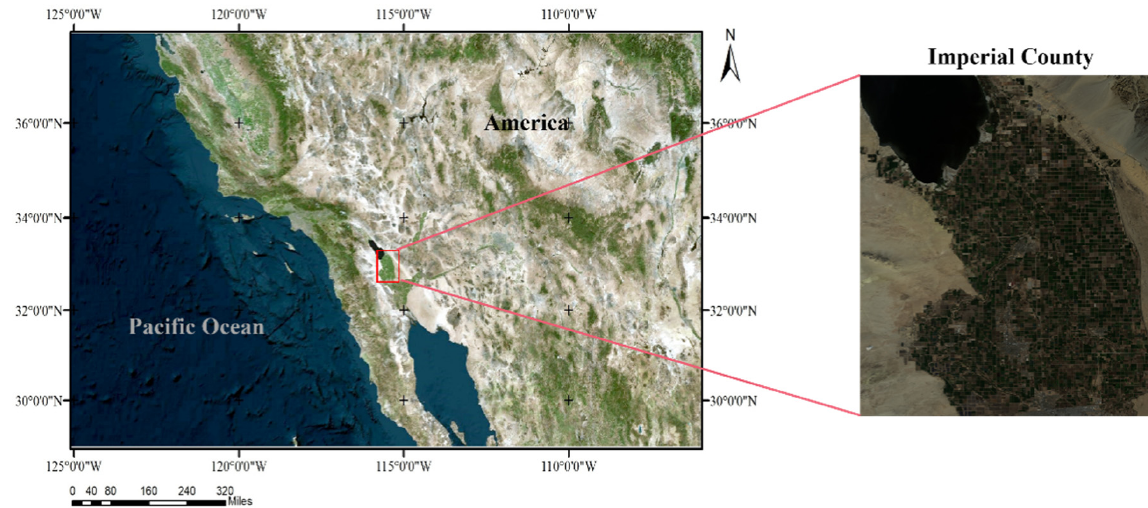
Figure 3. The overview of the Imperial Dataset.